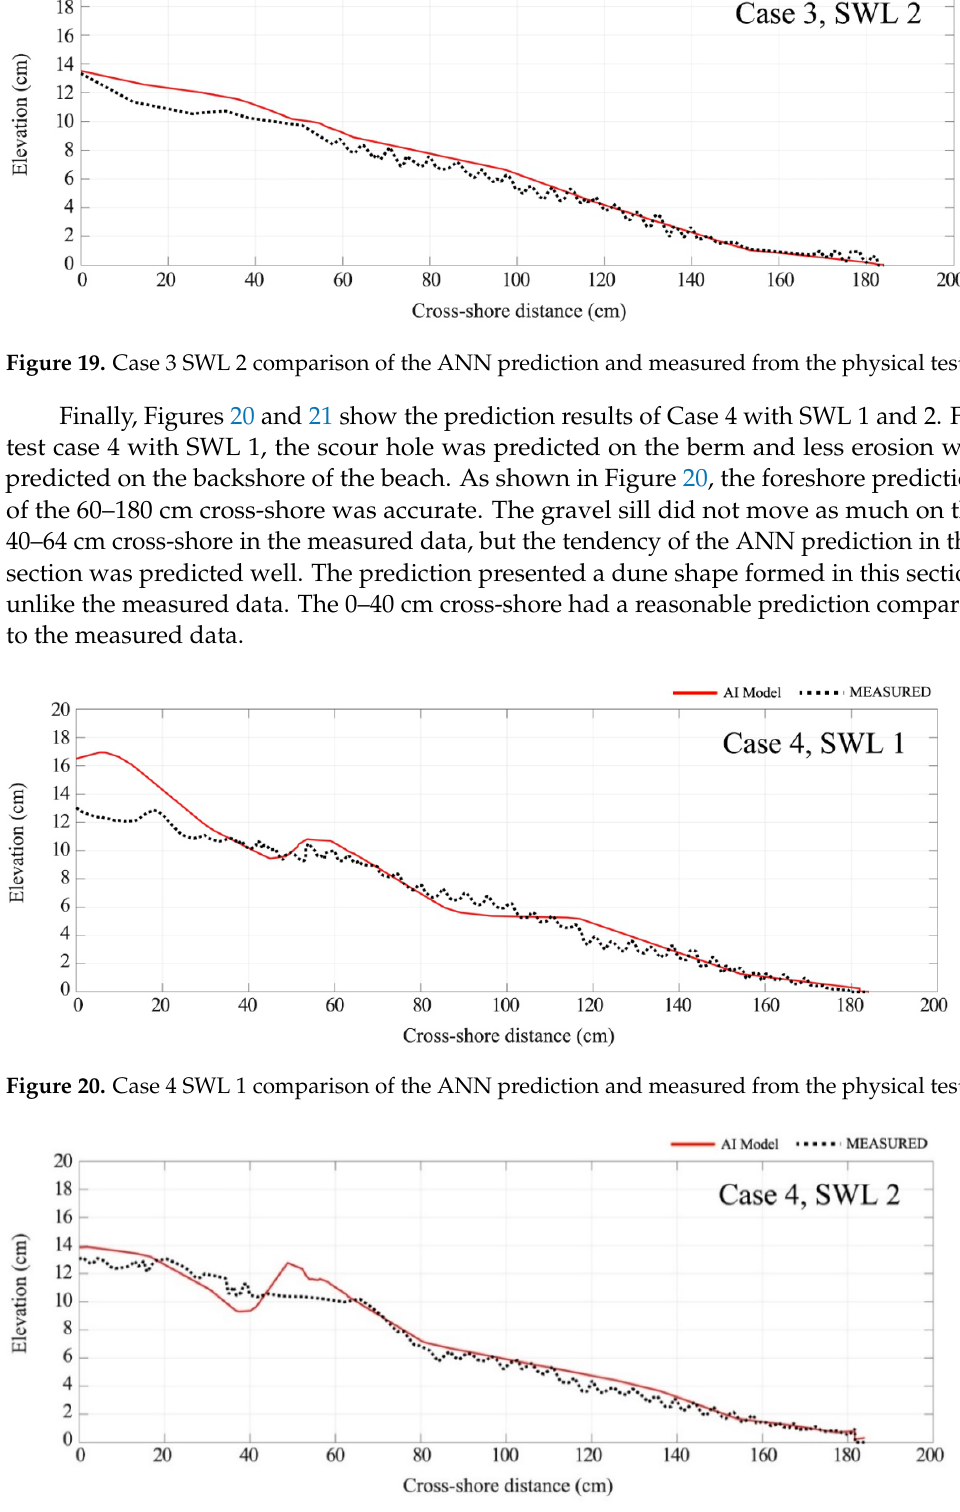
Figure 18. Case 3 SWL 1 comparison of the ANN prediction and measured from the physical test.